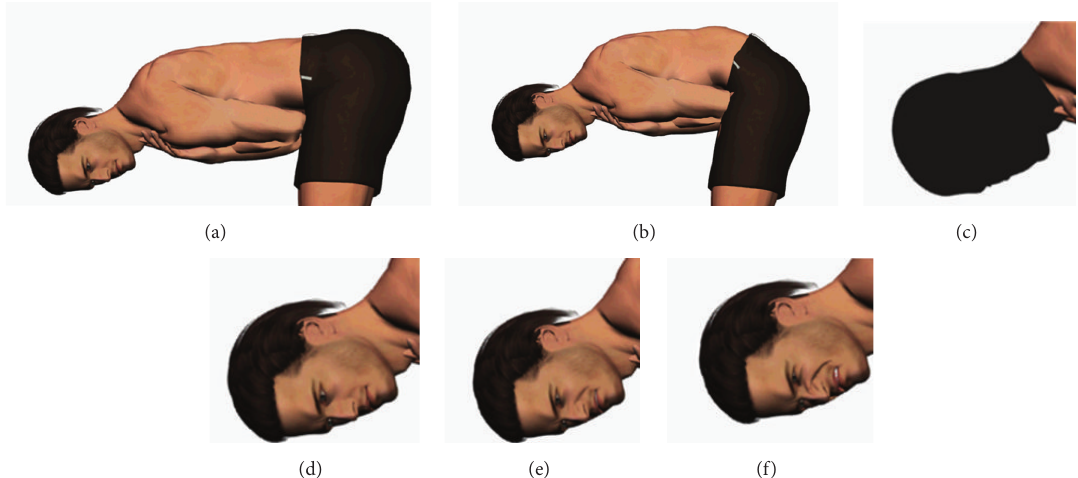
Figure 1: (a, b) Examples of trunk flexion frames taken from a video: (a) illustrates the prototypical low back pain lumbopelvic kinematics (“LBP LK”), whereas (b) represents the prototypical healthy lumbopelvic kinematics (“healthy LK”). (c–f) Examples of facial expression intensity (FEI): (c) corresponds to the masked FEI (“masked FEI”), (d) to “FEI 0%,” (e) to “FEI 50%,” and (f) to “FEI 100%.”